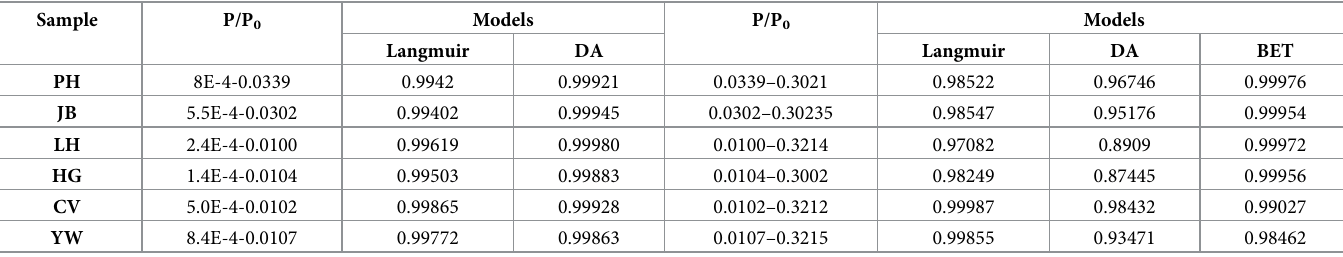
Table 4. Analysis results of coal samples with different coal ranks obtained using different adsorption models in different pressure regions. Sample P/P